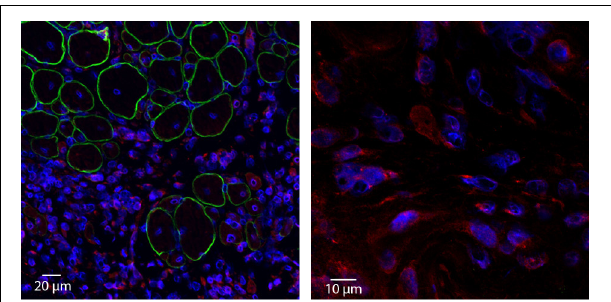
FIGURE 4 | Acute injury increases local Klotho expression within skeletal muscle. Young (3–4 months old) wild type animals were exposed to a cardiotoxin injury to the tibialis anterior muscle. Two weeks after injury, TAs were harvested, cryosectioned and incubated with anti-Klotho (red), anti-Dystrophin (green) and nuclear (blue) antibodies ( left image ; 20 × magnification). Corresponding high magnification image ( right image ; 100 × magnification). Note that Klotho is undetectable in areas of more mature, regenerating myofibers. In contrast, strong expression of Klotho is observed in the area of cellular